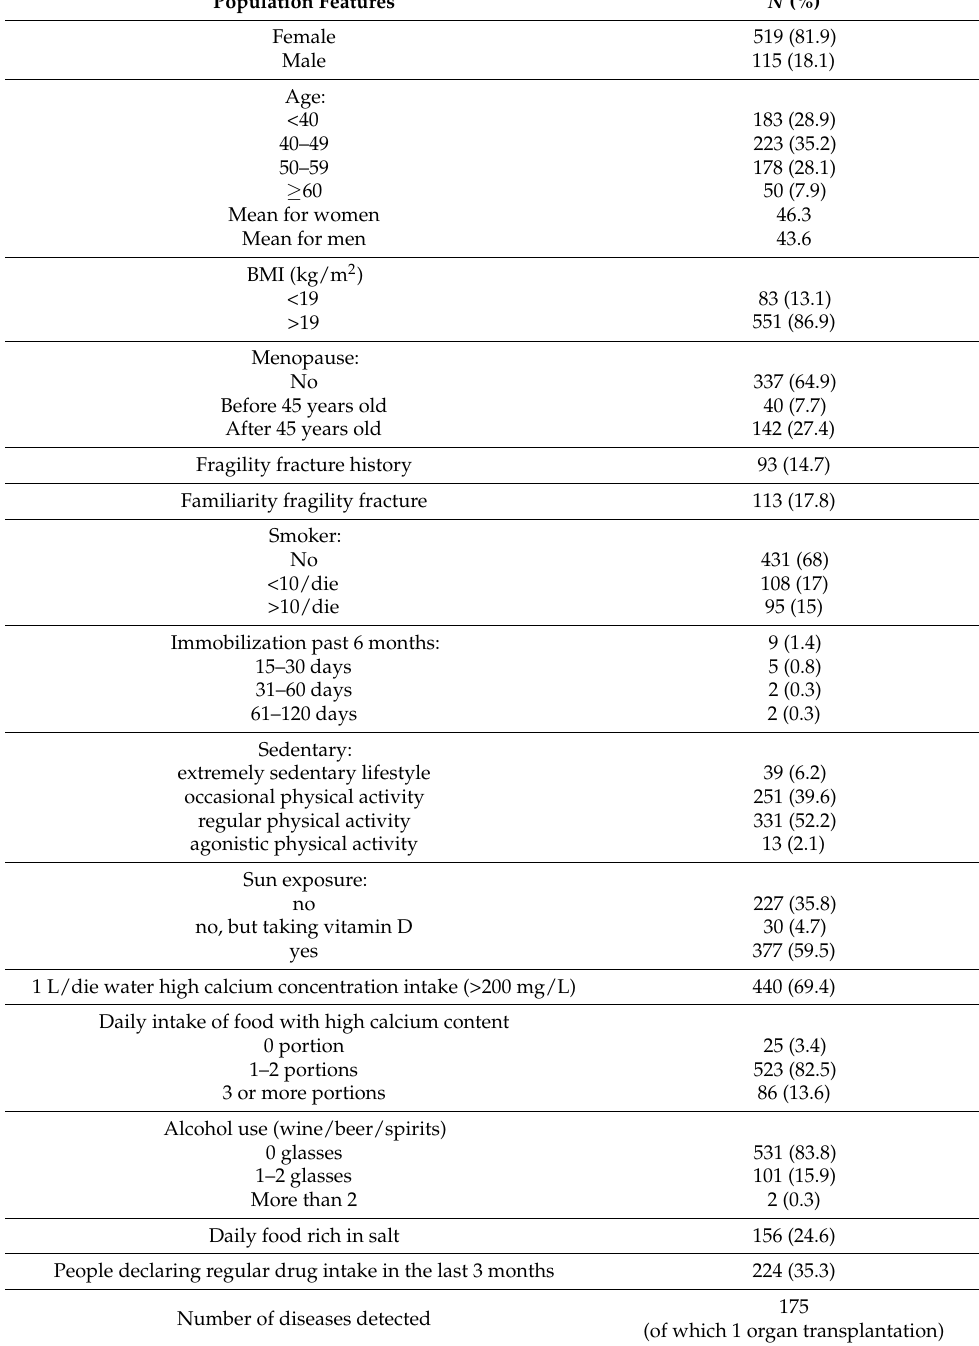
Table 1. Total population features ( N